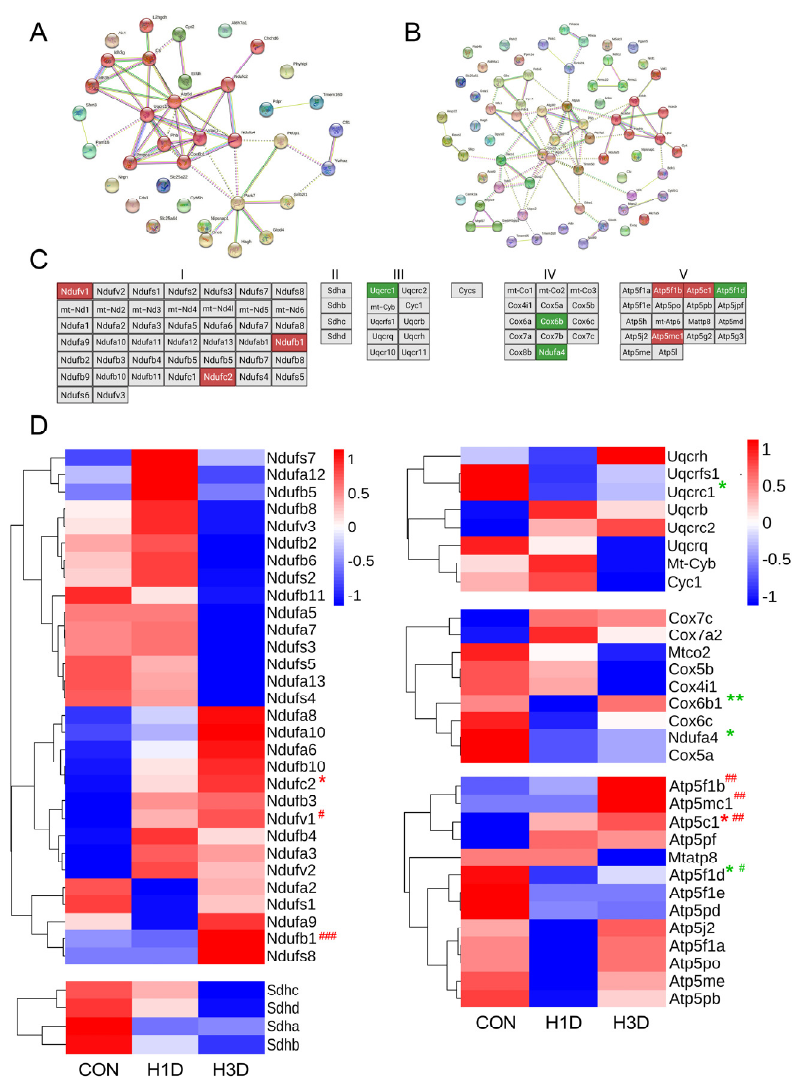
Figure 5. Hypoxic stress impaired mitochondrial oxidative phosphorylation by suppressing mito- chondrial complex IV. ( A , B ) The differentially expressed mitochondrial-related proteins compared with the CON had a multiprotein interaction network constructed by the STRING Database in H1D ( A ) and H3D ( B ) mice. ( C ) The newly reported mitochondrial electron transport chain complex pro- teins. The red represents upregulation, the green downregulation, and the gray no change or uni- dentified. ( D ) The list of mitochondrial oxidative phosphorylation proteins. The red represents up- regulation (FC ≥ 1.2, * p < 0.05 H1D vs. CON, # p < 0.05, ## p < 0.01, ### p < 0.001 H3D vs. CON), green downregulation (FC ≤ 0.67, * p < 0.05, ** p < 0.01 H1D vs. CON, # p < 0.05 H3D vs. CON).